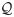
Locus of the trendline parameters (a, b) in the Cartesian plane, Q, for the arc-cosine distance dijA and the 11 countries analyzed, t ∈ [1960, 2015].The diameter and color of the circles are proportional to the value of R2. The dashed line delimits the clusters C1 and C2.